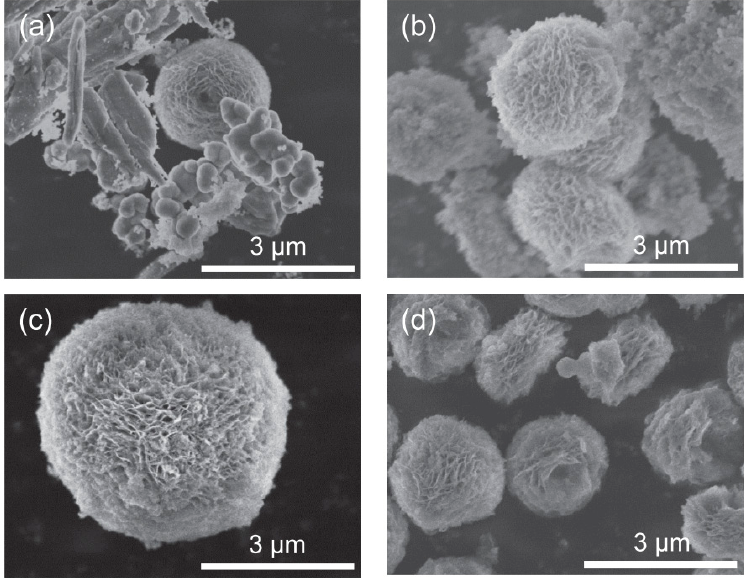
Figure 7. FESEM images of flowerlike CeO 2 -ZrO 2 developed using a two-step hydrothermal process: ( a ) CZ(2Hyd0.5a) and ( b ) CZ(2Hyd0.5b). ( c , d ) are the Ce(OH)CO 3 precursors after 72 and 48 hours, respectively, of the initial hydrothermal process (1st step). Figure republished with permission from [97]. Copyright Elsevier, 2021.